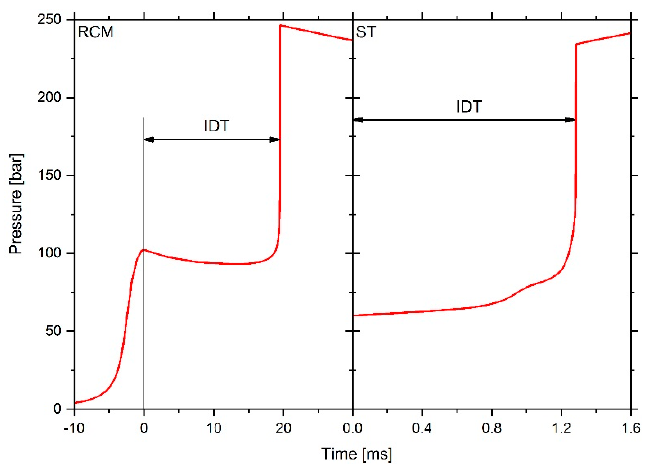
Figure 1. Simulated pressure curve and ignition delay time (IDT)-definition for rapid compression machine (RCM) ( left ) and shock tube (ST) ( right ).